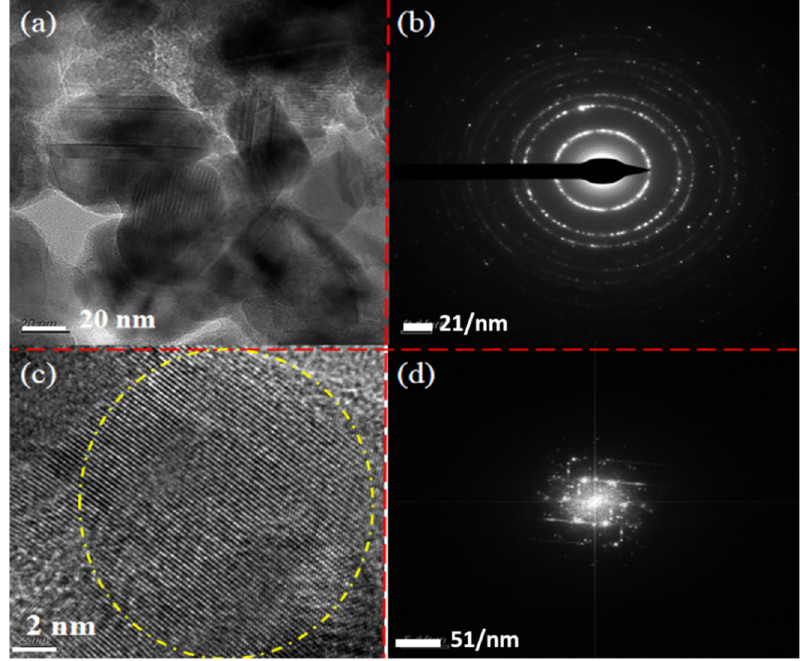
Figure 5. TEM ( a ), SAED pattern ( b ), HR-TEM ( c ), and corresponding FFT ( d ) images of CrSiN coatings deposited under arc currents of 70 A.